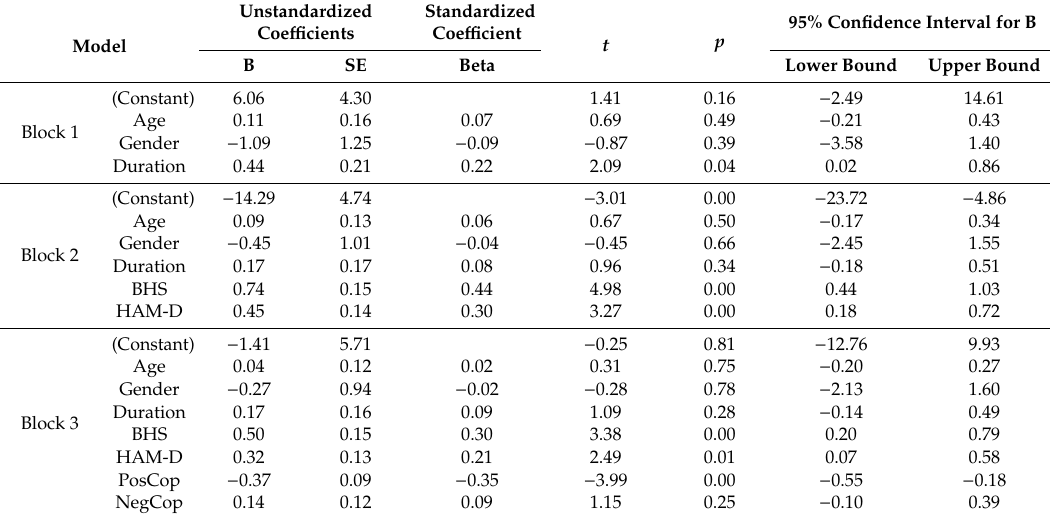
Table 1. Results of the linear regression analysis with Scale of Suicide Ideation (SSI) as the dependent variable and other variables as